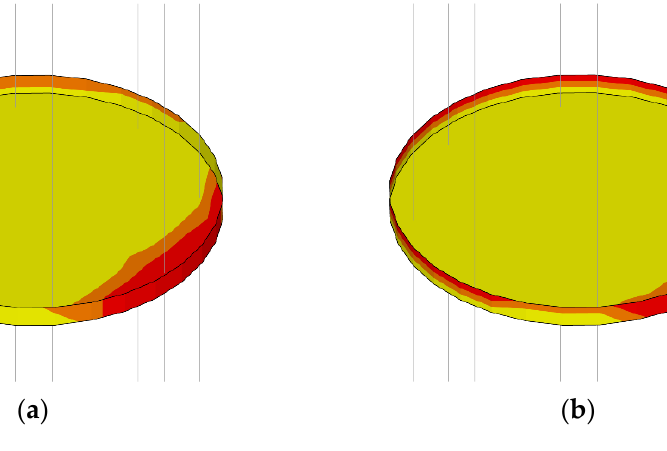
Figure 13. PMR’s contact status diagrams at the displacement of ( a ) 50 mm and ( b ) 160 mm.